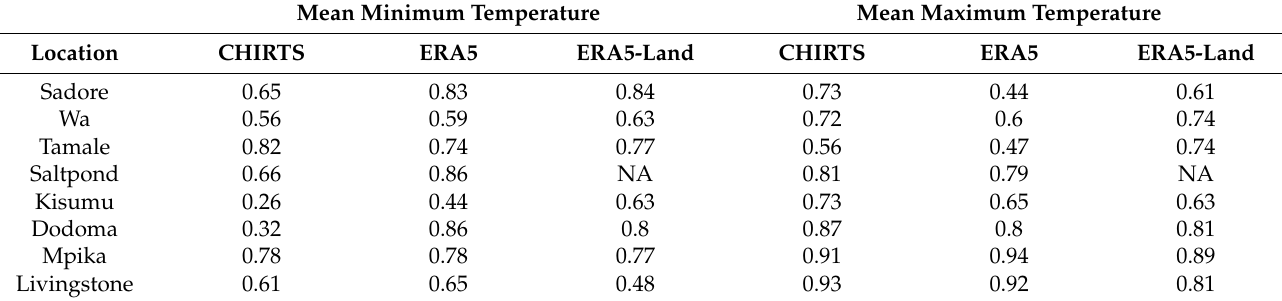
Table 6. Correlation between station and product mean minimum temperatures and station and product mean maximum